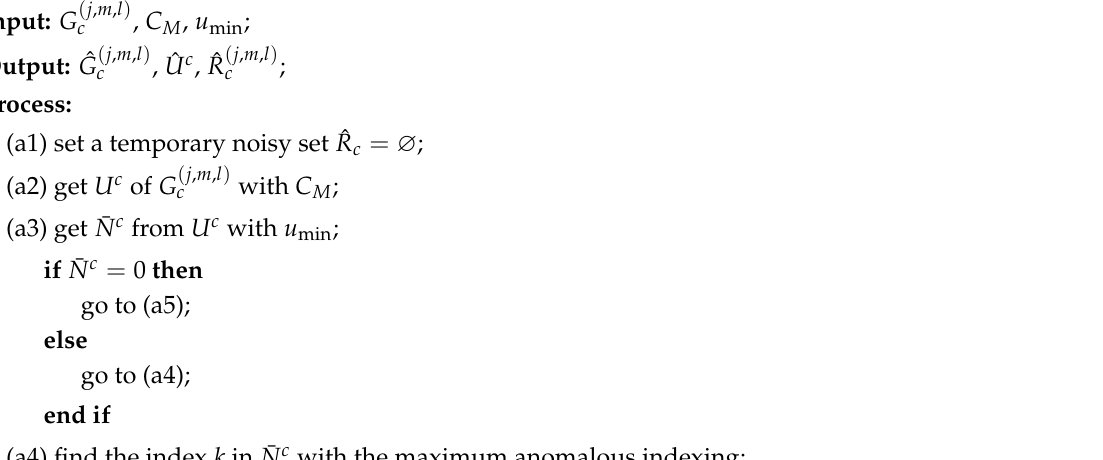
Algorithm 3 Trajectory fragment cleaning